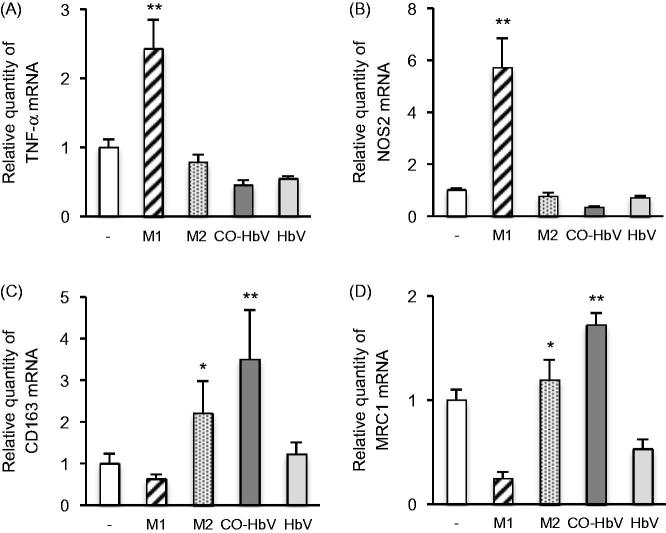
The changes of mRNA expression of (A) TNF-α, (B) NOS2, (C) CD163 and (D) MRC1 after incubation with either M1-trophic cytokines (LPS and IFN-γ), M2-trophic cytokines (IL-13 and IL-4), CO-HbV or HbV in RAW 264.7 cells. TNF-α and NOS2: M1 macrophage marker, CD163 and MRC1: M2 macrophage marker. Error bars indicate the S.E. of six separate experiments. *p < .05,**p < .01 versus non-treatment.